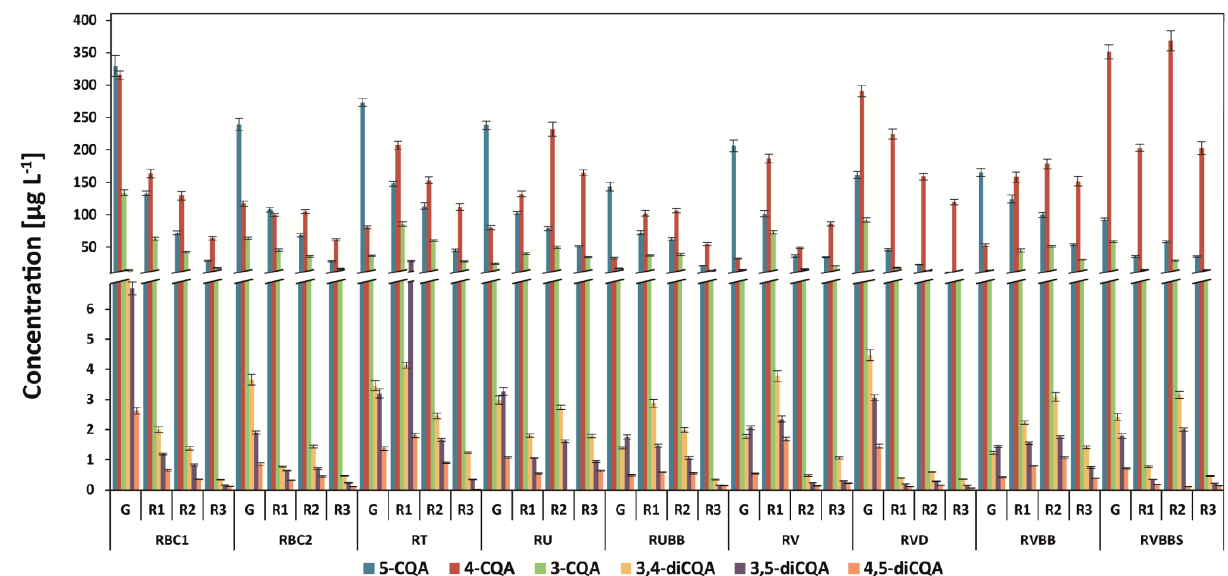
Figure 2. Chlorogenic acid (caffeoylquinic acids isomers—CQA) content in Robusta coffee brews. Legend: information about the coffees is provided in Figure 1.